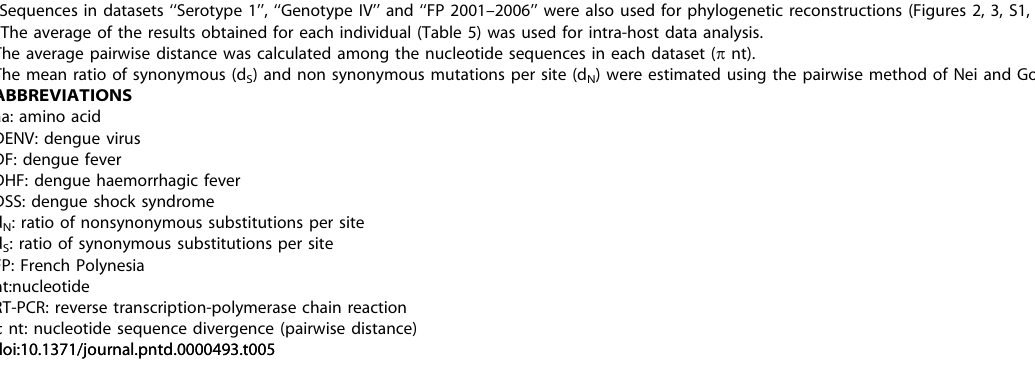
The average pairwise distance was calculated among the nucleotide sequences in each dataset ( p nt). The mean ratio of synonymous (d S ) and non synonymous mutations per site (d N ) were estimated using the pairwise method of Nei and Gojobori.